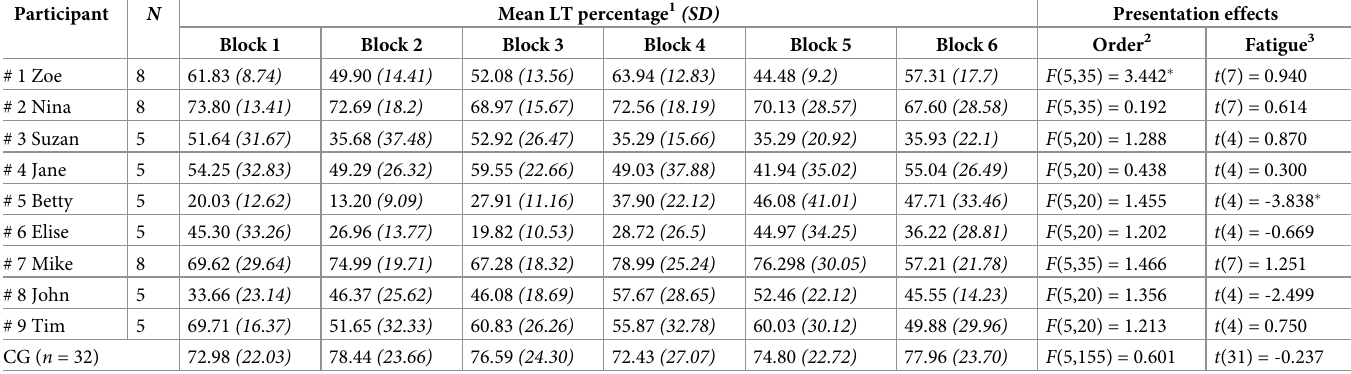
1 . Calculated as the time spent looking at the screen during the presentation of each block at the different sessions performed divided by the blocks’ duration. 2 . Main effect of the order of presentation of the six blocks tested using within-subject repeated measure ANOVAs. 3 . Fatigue effect tested using contrast analyses comparing the individual mean LT percentages on the first two blocks presented vs. the last two. � p < .05.